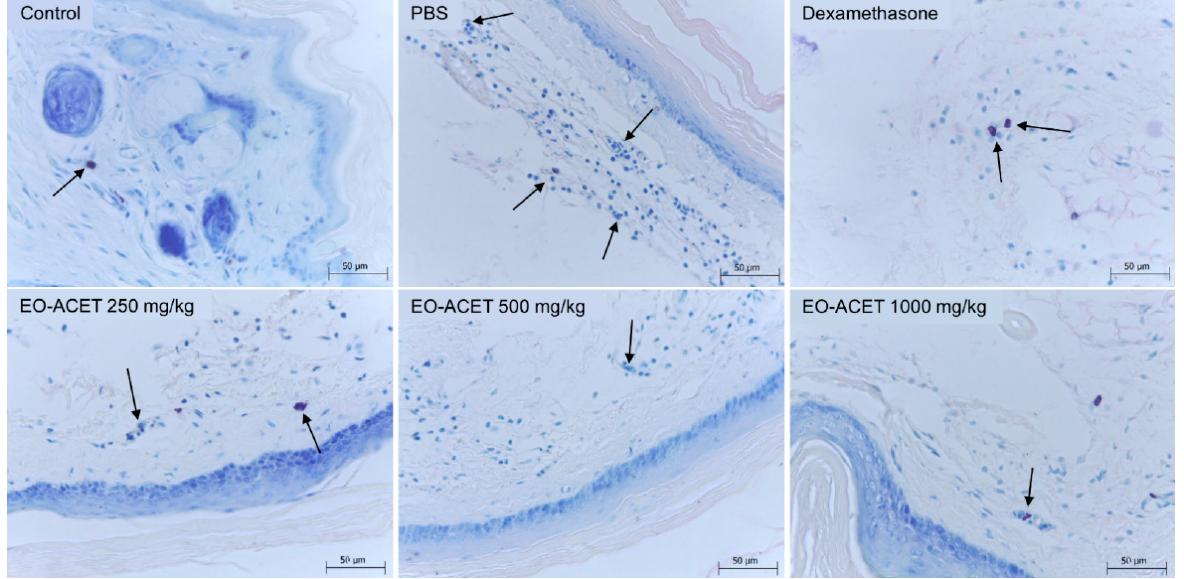
Figure 6. Mast cells (arrows) histology of BALB/c mice inoculated with of λ -carrageenan and treated with Euterpe oleraceae ethyl acetate fraction (EO-ACET). Animals inoculated with 25 µL of λ -carrageenan 1% and treated with 100 µL EO-ACET by gavage or with dexamethasone 5 mg/kg via the intramuscular route. Wolbach Giemsa Stain.